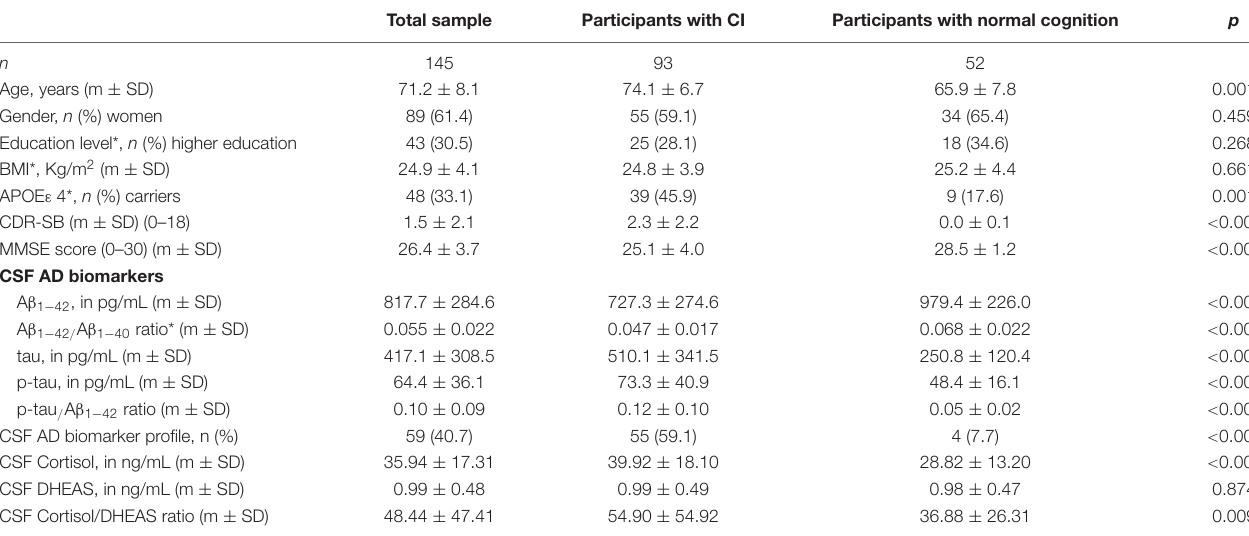
TABLE 1 | General characteristics of the studied sample at